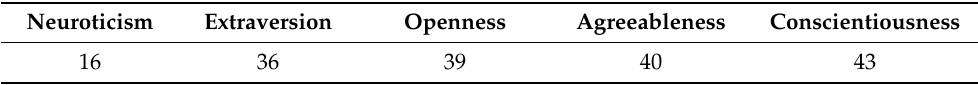
Table 10. Characteristics of personality of the tested ultramarathon runner.